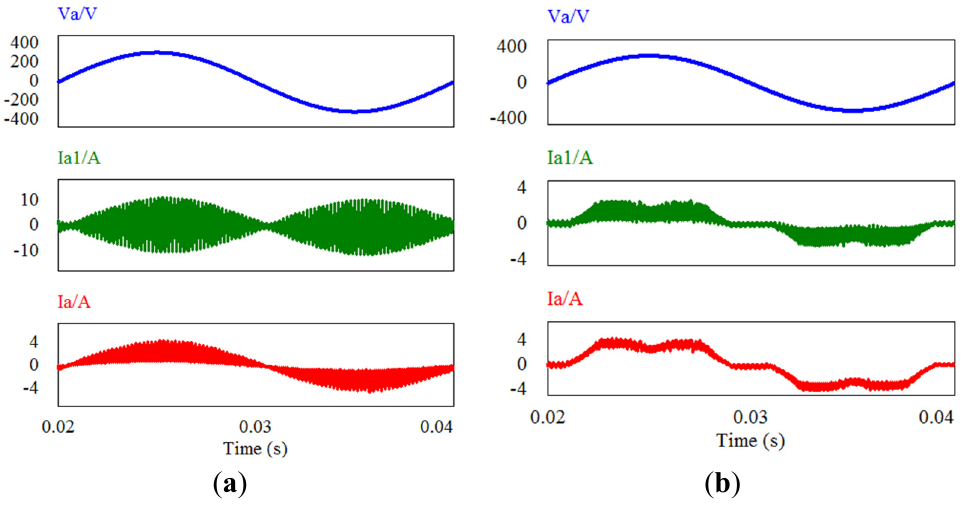
Figure 17. Simulated waveforms: ( a ) PFM; ( b ) the proposed hybrid PFM control strategy.